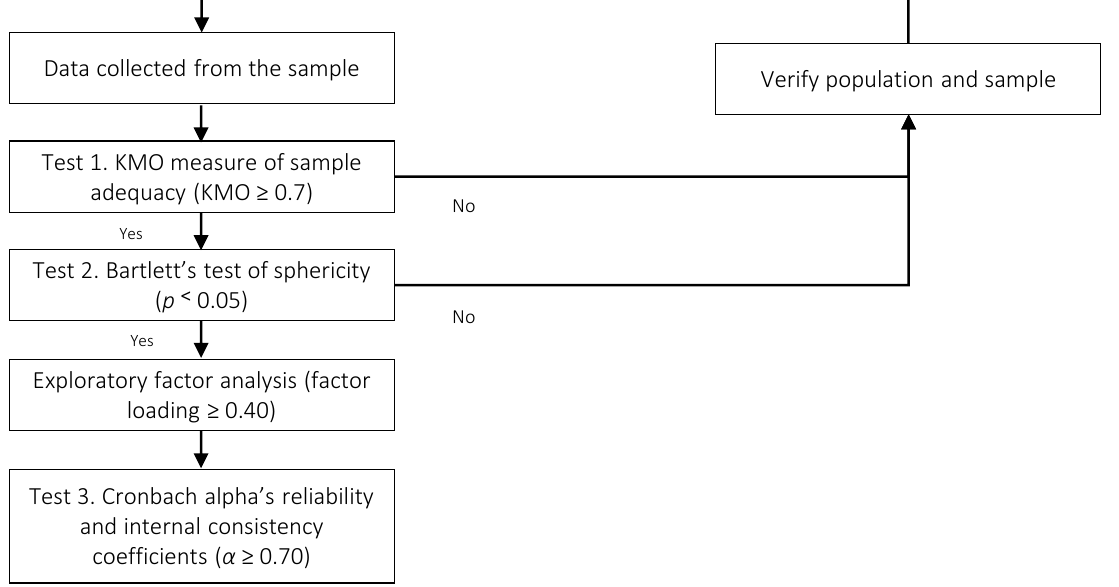
Figure 1. Data analysis flow